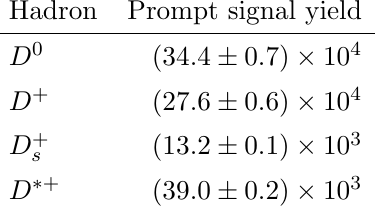
Table 1. Prompt signal yields in the fully selected dataset, summed over all ( p T ; y ) bins in which a measurement is made. Only statistical uncertainties are